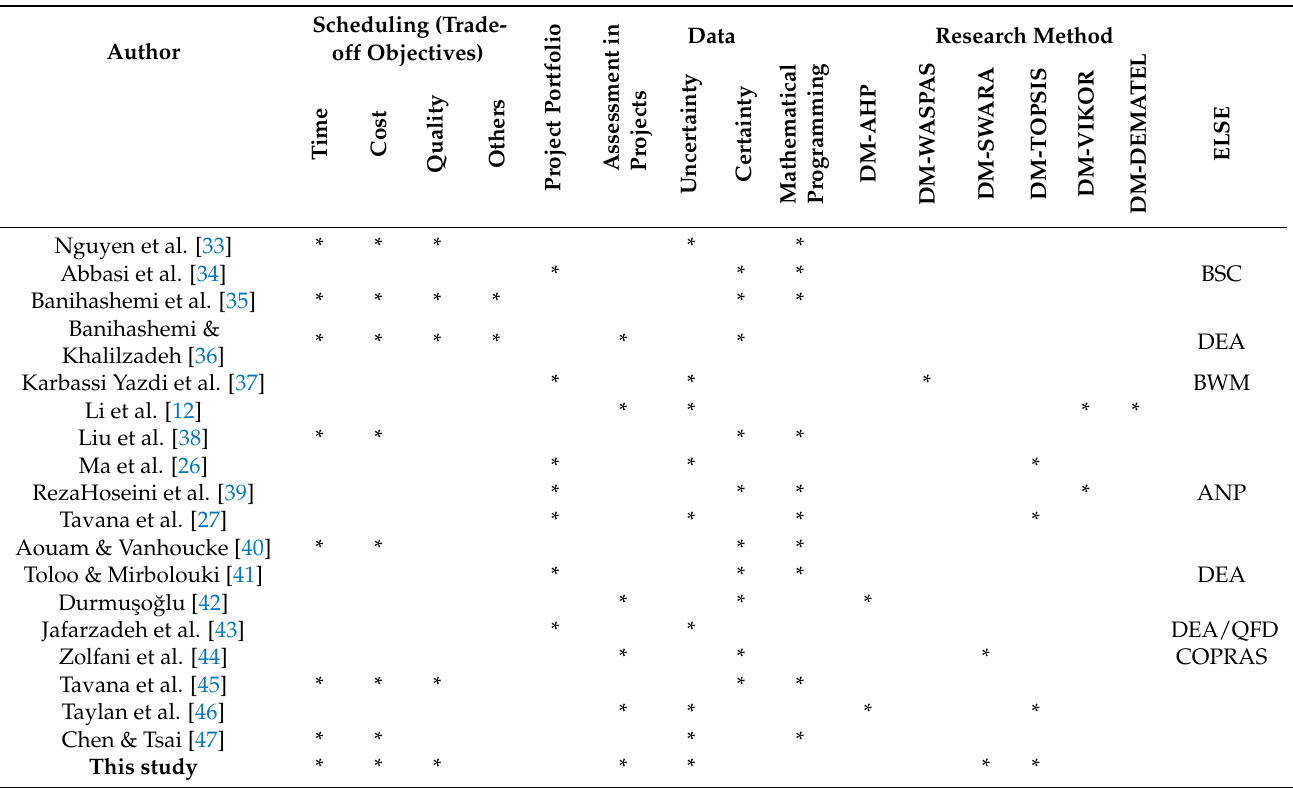
Table 1. A brief review of related